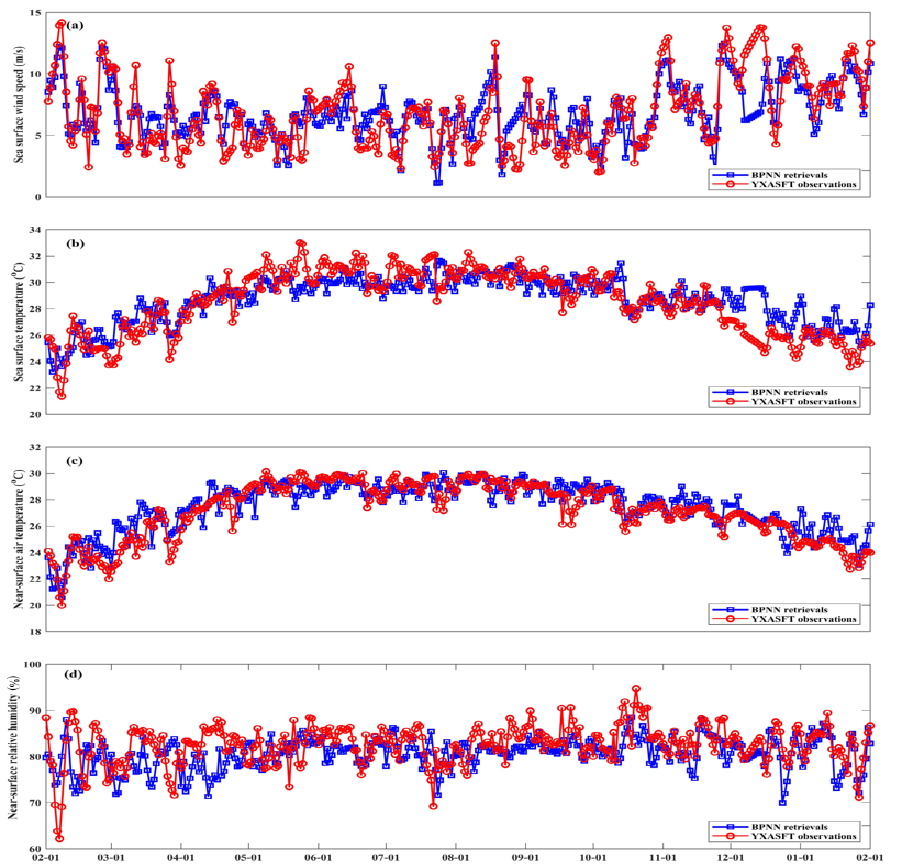
Figure 5. Daily time-series plots of the YXASFT-observed (red solid lines) and BPNN-retrieved (blue solid lines) ( a ) sea surface wind speed (WS), ( b ) sea surface temperature (T s ), ( c ) near-surface air temperature (T a ), and ( d ) relative humidity (RH) values over a period of 1 year (from 1 February 2016 to 31 January 2017).